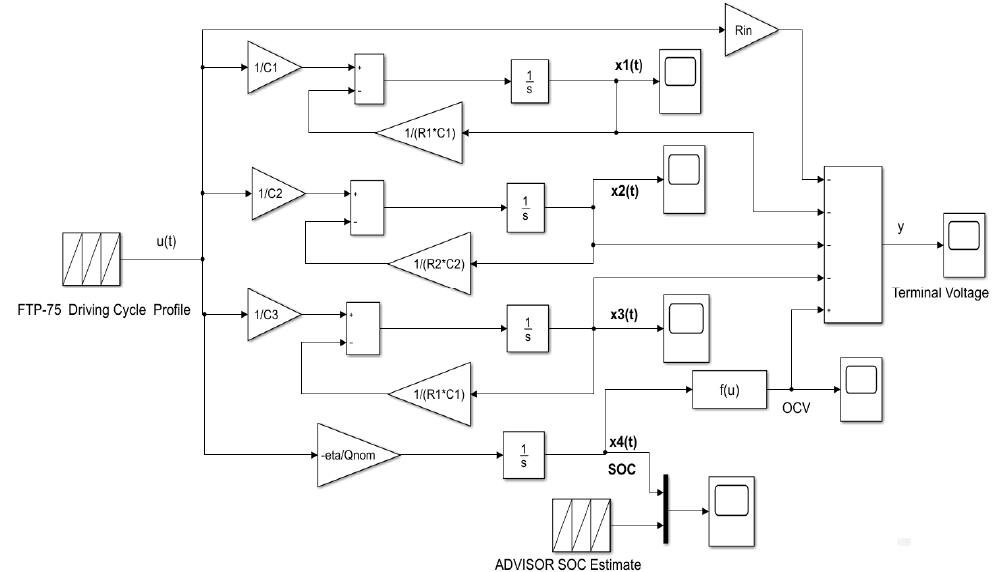
Figure 7. The Simulink diagram of third order 3RC ECM–Li-Ion battery model.